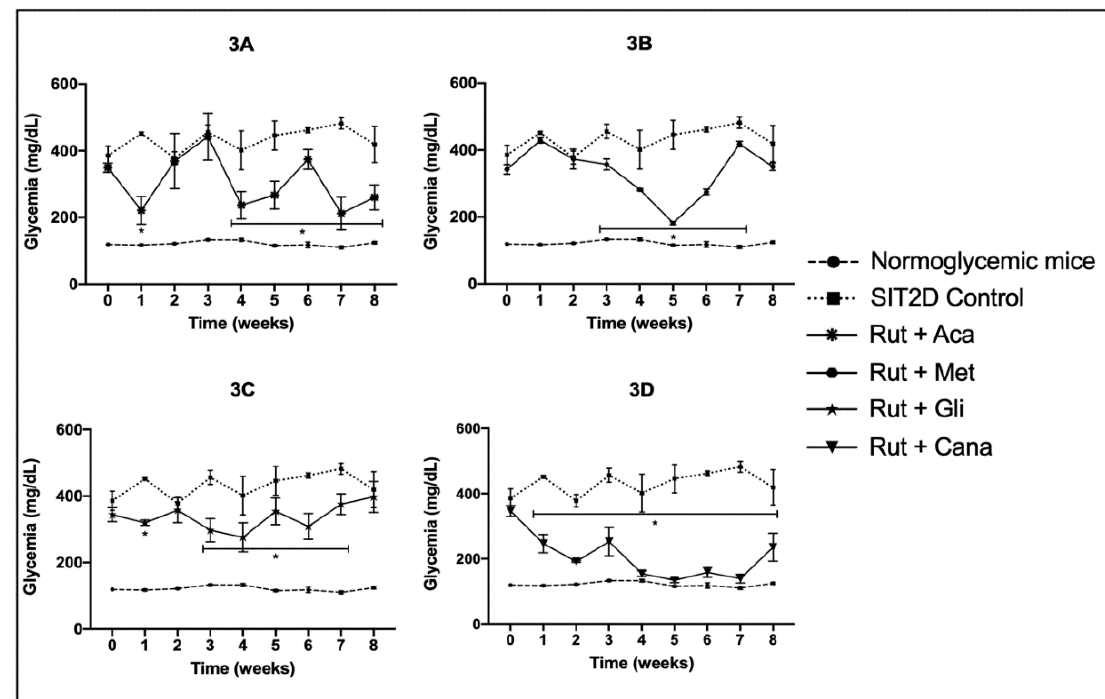
Figure 3. Effect over glycemic values of combined administration of the oral antidiabetic drugs with rutin in SIT2D mice compared with SIT2D and normoglycemic control groups. Groups treated with rutin 50 mg/kg + acarbose 50 mg/kg ( 3A ), rutin 50 mg/kg + metformin 850 mg/kg ( 3B ), rutin 50 mg/kg + glibenclamide 5 mg/kg ( 3C ), rutin 50 mg/kg + canagliflozin 50 mg/kg ( 3D ). Results are expressed as the mean ± SEM, n = 6, * p < 0.05 vs. SIT2D control at same week of